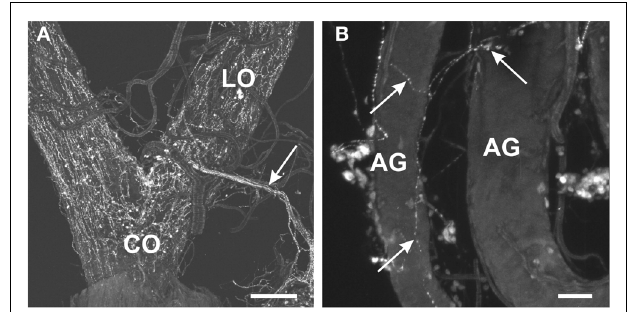
FIGURE 3 | Myoinhibiting peptides-like immunoreactivity is associated with the female and male reproductive tissues of R. prolixus . (A) MIP-like axons are present in the oviducal nerve (arrow) and immunoreactive processes are associated with both the lateral oviducts (LO) and common oviducts (CO). (B) A fine network of MIP-like immunoreactive processes (arrows) is evident around the male accessory glands (AG). Scale bars: (A) , 200 µ m; (B) , 50 µ m.